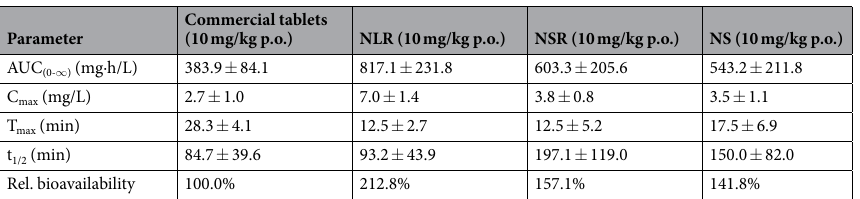
Table 3. Pharmacokinetic parameters of commercial tablets, NI loaded NLR, NI loaded NSR, NI loaded NS after intragastric administration in rats, mean ± S.D., n =